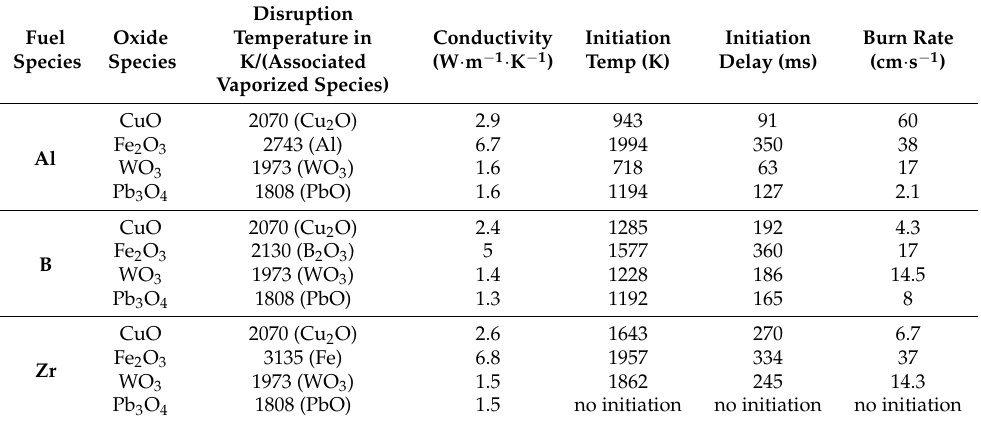
Table 1. Calculated system disruption, defined as the temperature of first vaporization among all thermite basic components, effective thermal conductivity, initiation temperature, initiation delay, and burn rate for Al, B, and Zr fuel based